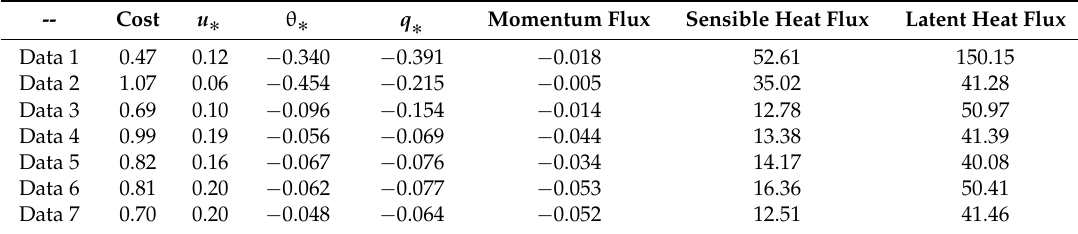
Table 1. Results of MASL scaling parameters, surface fluxes, and magnitude of the least-squares cost function. The momentum flux is shown in N ¨ m ´ 2 , while the sensible and latent heat fluxes are shown in W ¨ m ´ 2 . The units for u ˚ , θ ˚ , q ˚ are m ¨ s ´ 1 , K, and g ¨ kg ´ 1 ,